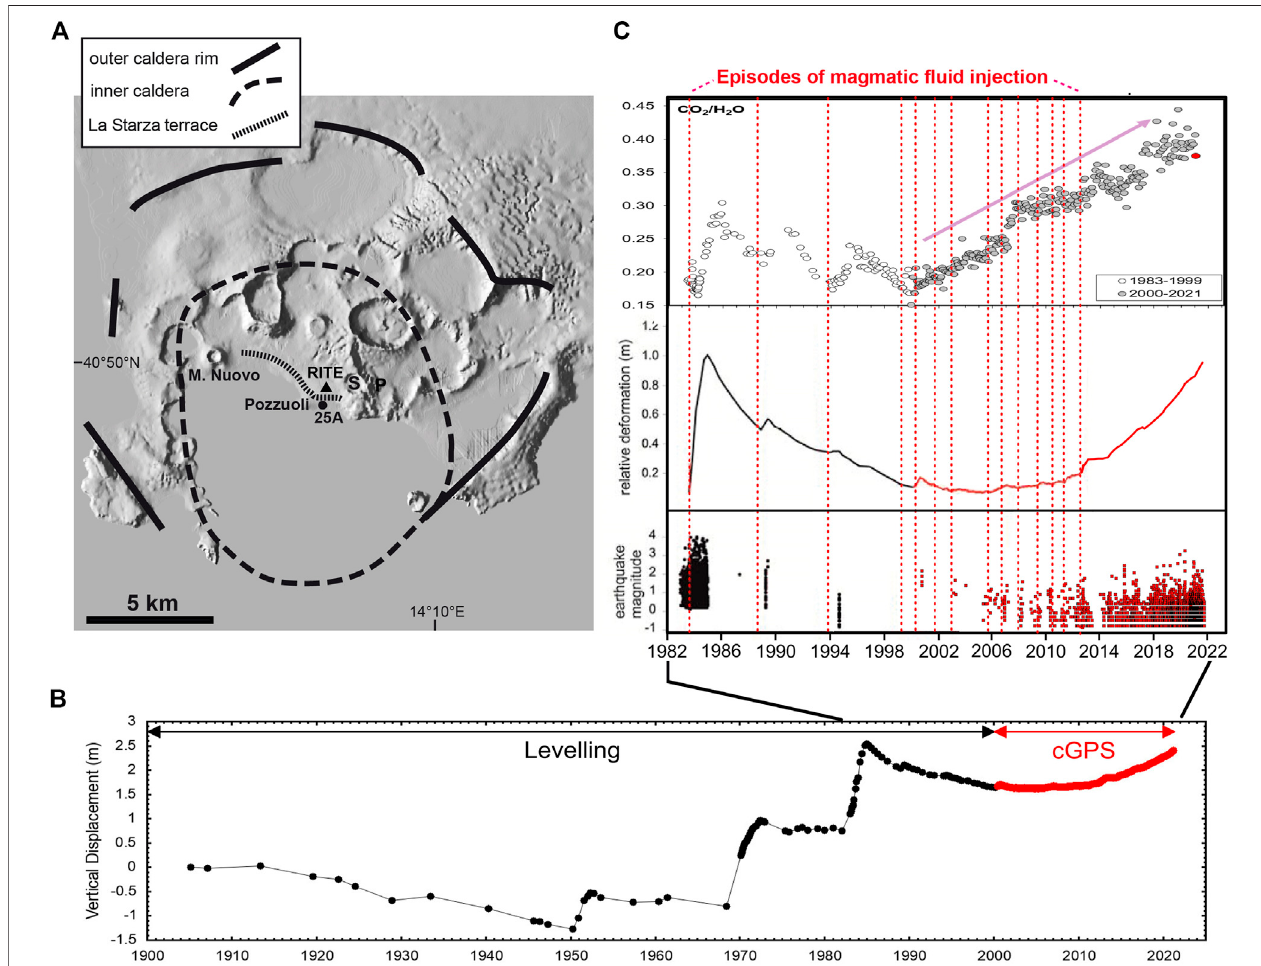
FIGURE 3 | (A) Simpli fi ed structural map of Campi Flegrei caldera, Italy, including the location of the resurgent dome (highlighted by the La Starza marine terrace between Pozzuoli and Monte Nuovo). S indicates La Solfatara crater and P the Pisciarelli fumaroles, where the maximum fl uid fl ux is currently detected; (B) Elevation changesof benchmark 25a(location in a) from 1905to 1999(after DelGaudio et al.,2010) merged with more recent (2000 – 2020) vertical displacement at cGPS station RITE (location in a); (C) Measured fumarolic CO 2 /H 2 O ratio (top); ground deformation (centre) and earthquake magnitudes (bottom); dashed lines refer to times of injection of magmatic fl uids into hydrothermal aquifer (after Chiodini et al., 2012).